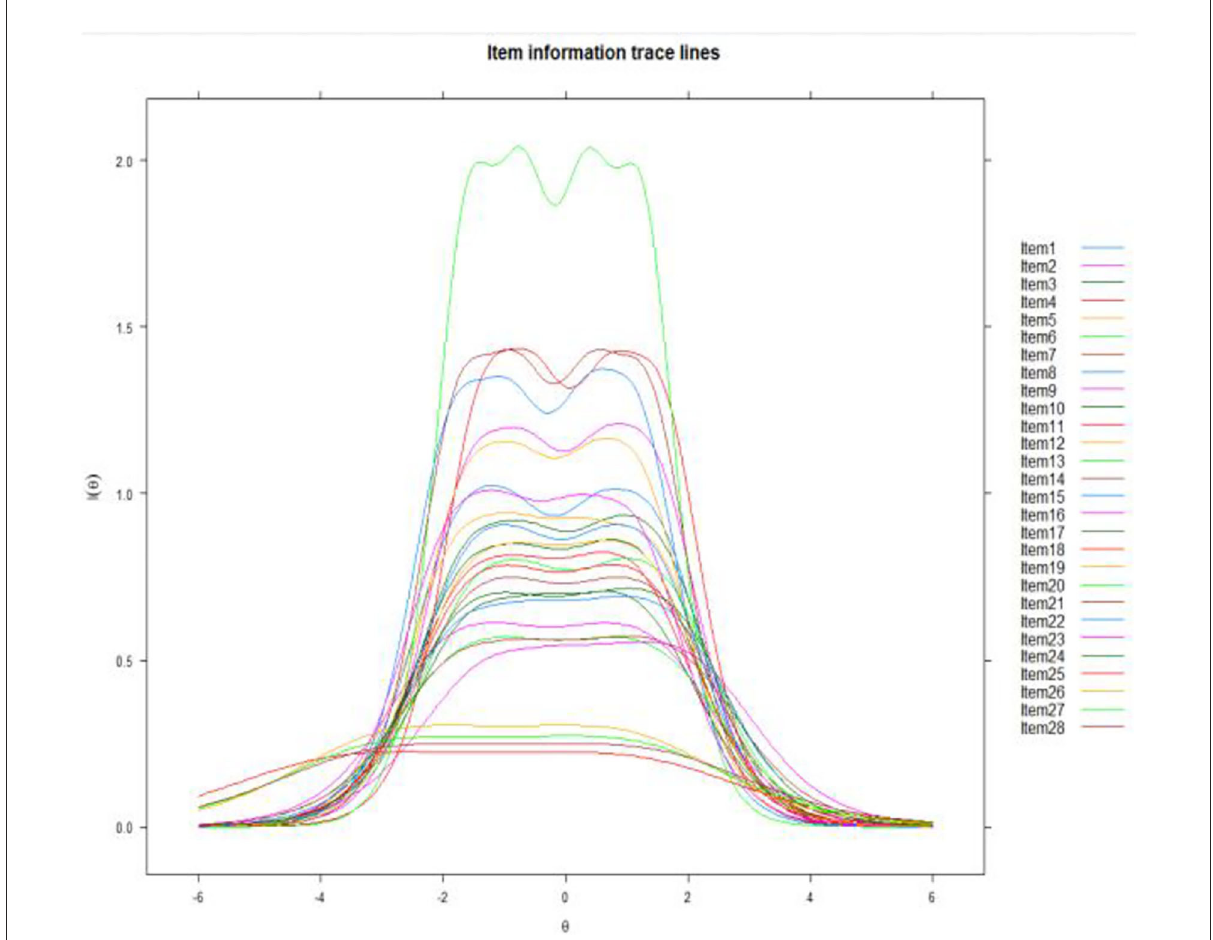
FIGURE2 Item information